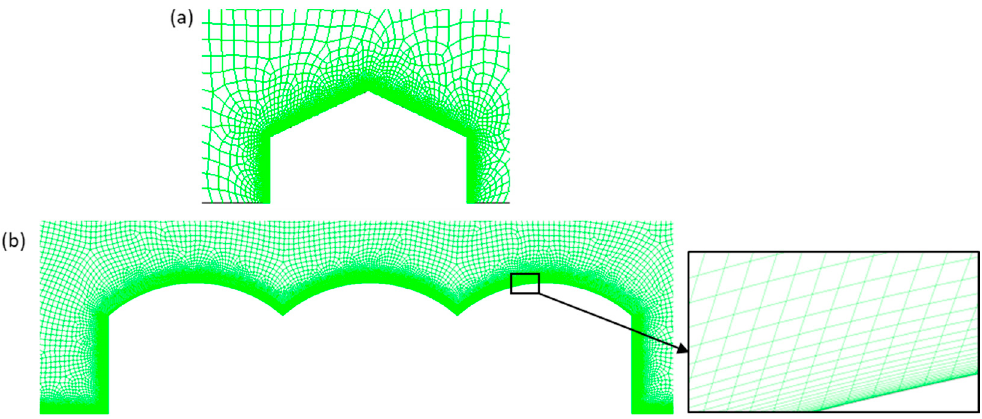
Figure 11. Mesh distribution for ( a ) the even-span greenhouse (EV-D22) defined in Kim et al. [44]; and ( b ) the multi-span greenhouse.